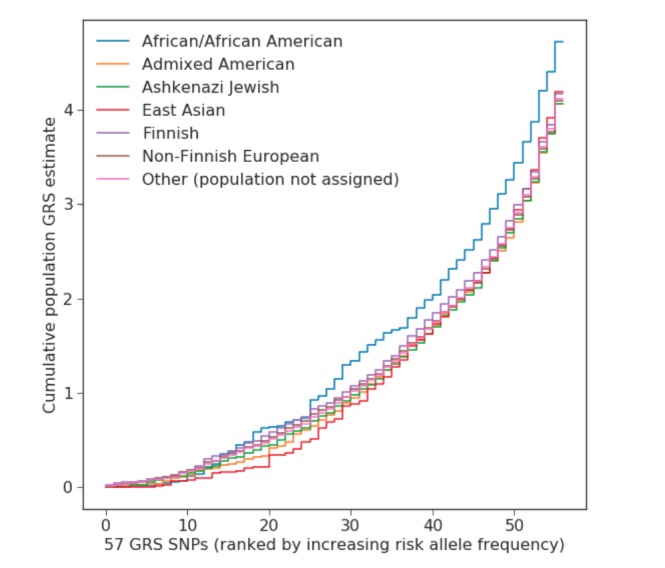
Genomic risk scores in gnomAD populations.Population-specific genomic risk scores (GRS) as seen based on gnomAD allele frequencies. Y-axis shows the cumulative effect of each of the 57 GRS SNPs; the X-axis is ordered by risk allele frequency. The population names displayed here follow the naming convention of the gnomAD database.